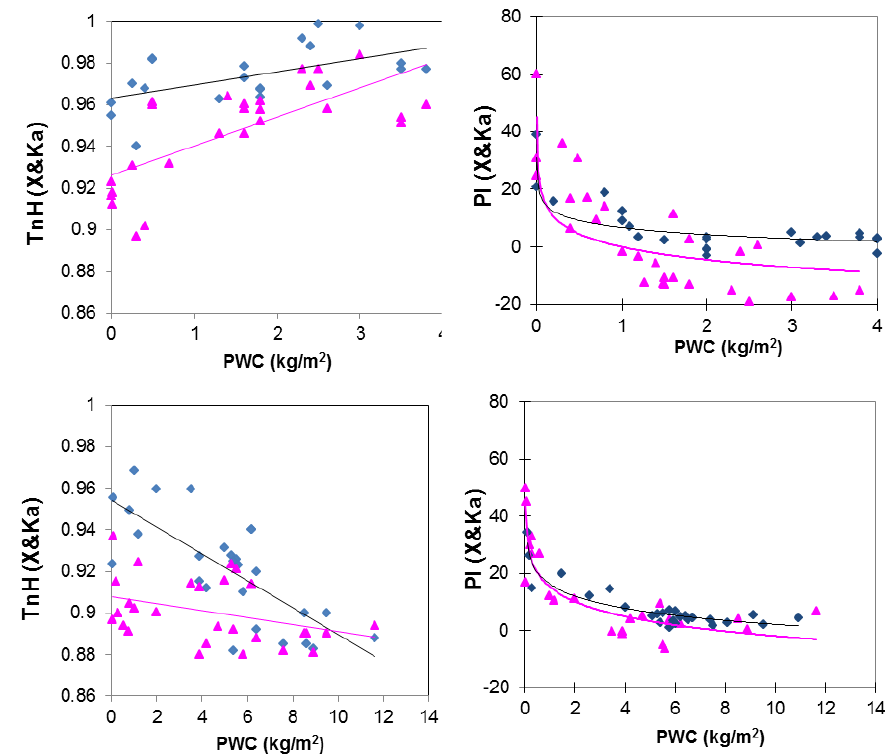
Figure 7. left: Normalized Temperature (Tn, in H pol.) at X (triangles) and Ka (rhombs) bands as a function of PWC, and right: PI at X and Ka bands as a function of PWC, for two different crop types: narrow-leaf crops (e.g., wheat and alfalfa) ( top ), and broad-leaf crops (e.g., corn, sugar beet and sunflower) ( bottom ).